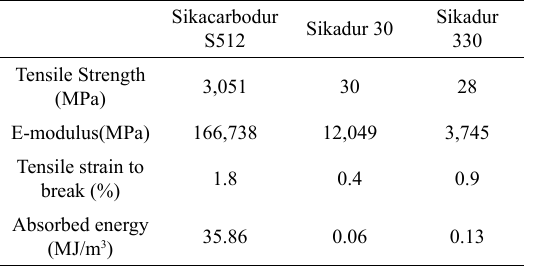
Table 2. Tensile Strength, Young Modulus and Tensile strain to break results for all studied materials. Sikacarbodur